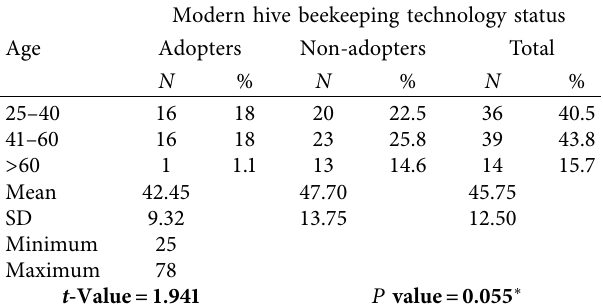
Table 6: Distribution of the level of education of the